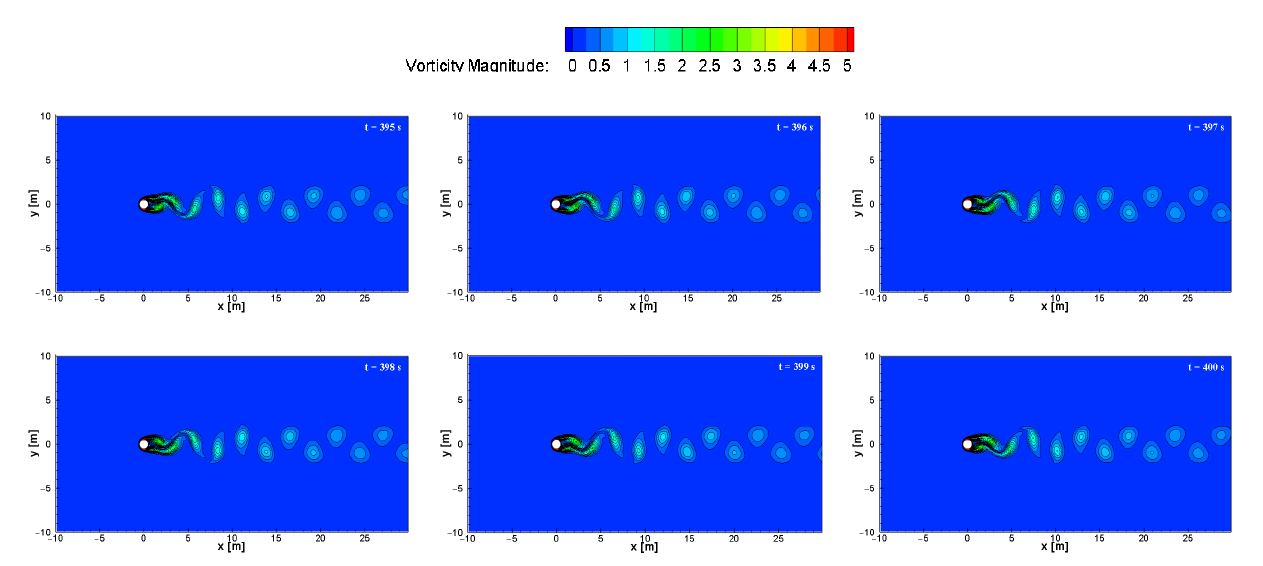
Figure 12. Contour maps of vorticity magnitude during approximately one cycle of vortex shedding ( Re = 100).